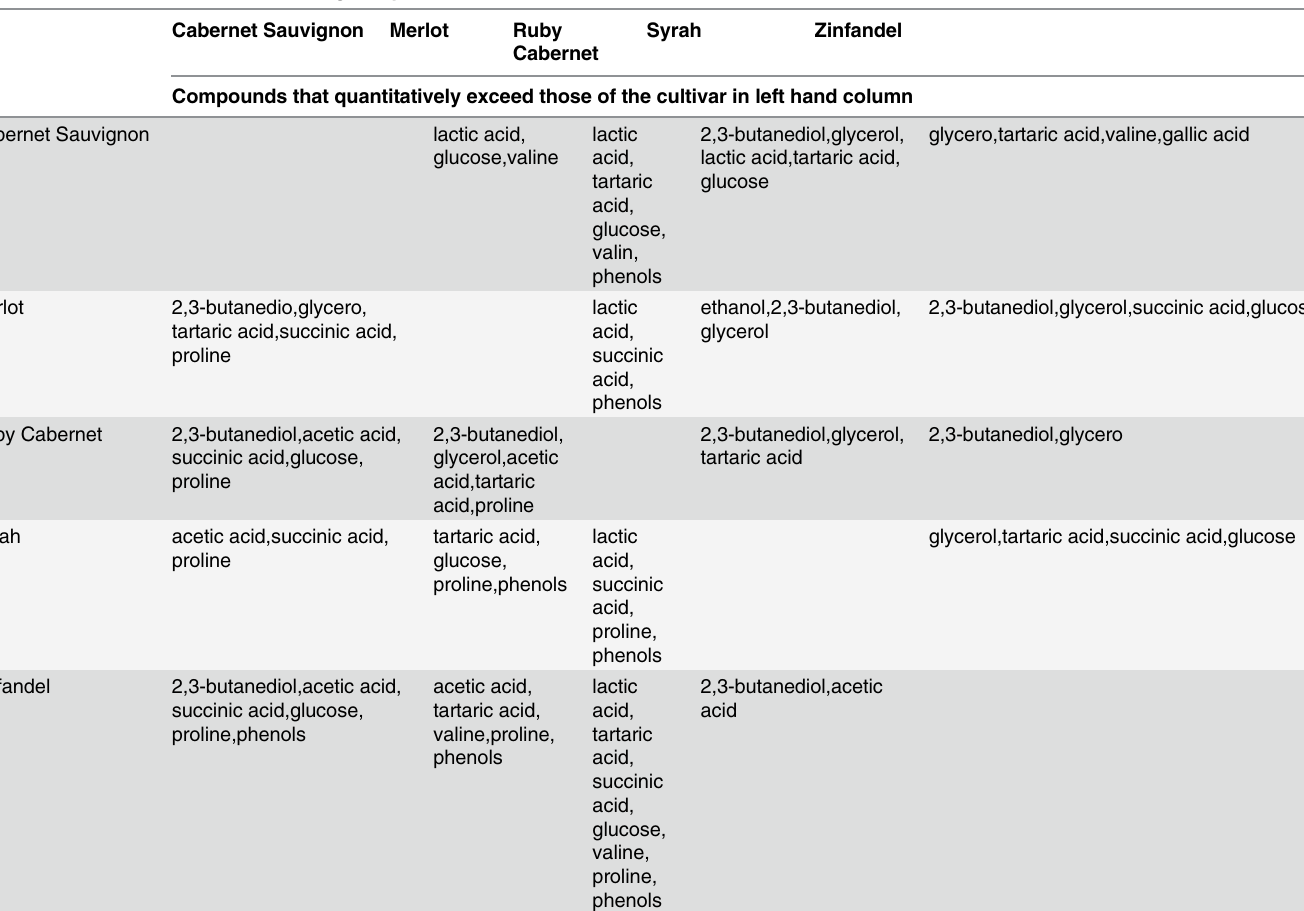
Table 4. Matrix of cultivar-discriminating compounds * .